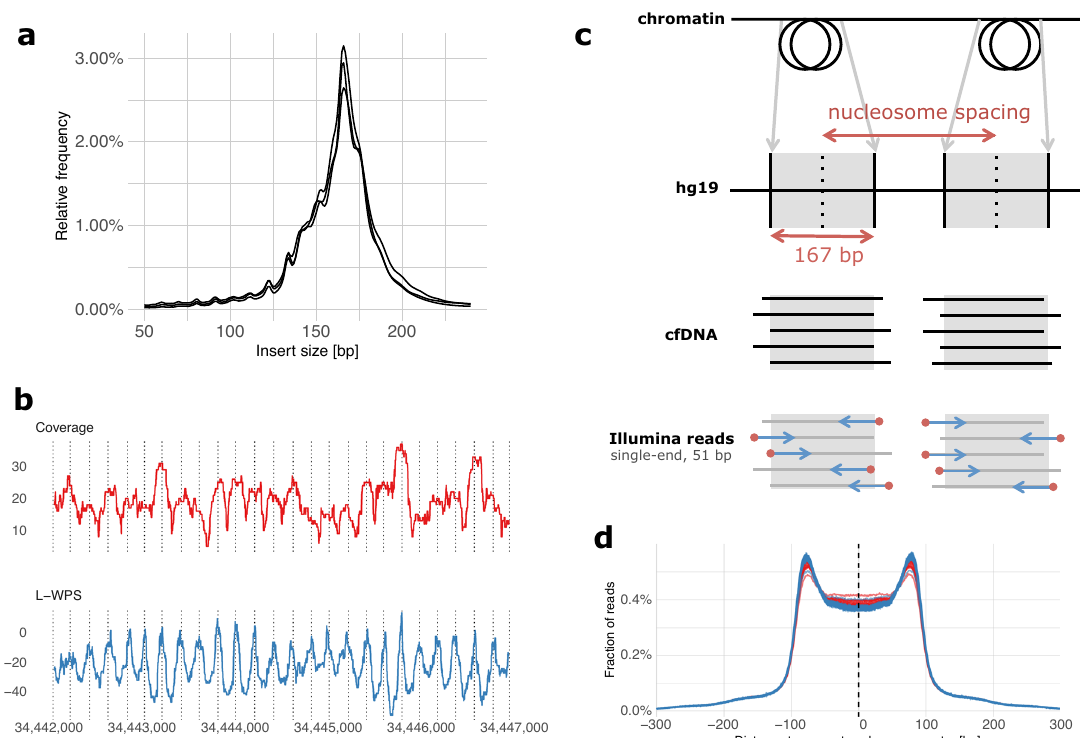
Fig. 1 Nucleosome footprint in paired-end and single-end cfDNA sequencing data. a The insert size distributions of three plasma samples sequenced at high coverage using paired-end sequencing data shows fragment lengths centered on the size of nucleosome-bound DNA. b Coverage and L-WPS score (as de fi ned by Snyder et al. 11 ; same genomic region is displayed) based on paired-end sequencing data of one plasma sample, illustrating speci fi c positioning of nucleosomes and their footprint in plasma cfDNA. c In single-end sequencing data, it is expected that mapped reads will tend to start (red dots) at the boundaries of nucleosomes. d When constructing a genome-wide distribution of the distances between all read start positions and the centers of the nearest expected nucleosomes as derived from a reference experiment in healthy individuals 11 , the result is an M-shaped distribution with an enrichment of read starts at the edges of nucleosomes and a depletion at the centers of nucleosomes. The distributions shown here are derived from cfDNA samples of 125 healthy individuals and 43 patients with relapsed HGSOC, shown in blue and red respectively. Compared to healthy individuals (blue), plasma samples of relapsed HGSOC patients (red) show a reduced enrichment of read starts at the nucleosome edges and a reduced depletion at nucleosome